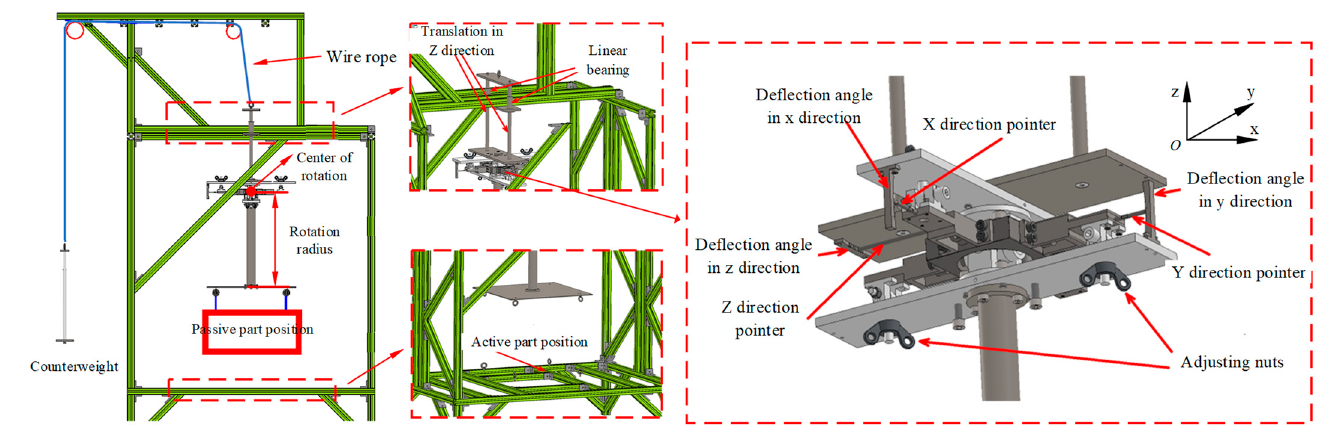
Figure 15. Capture and docking test platform.